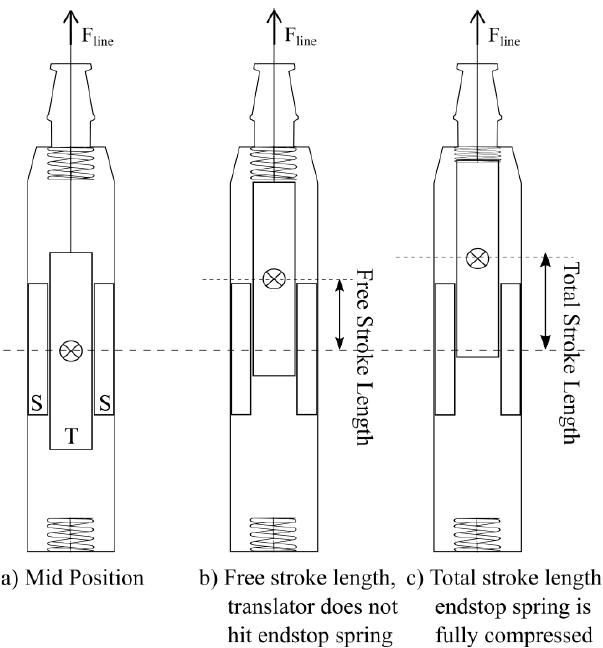
Fig. 1. The direct driven linear generator of Uppsala University’s WEC [16]. The generator is placed on the seabed and directly driven by the floating body through the connection wire.